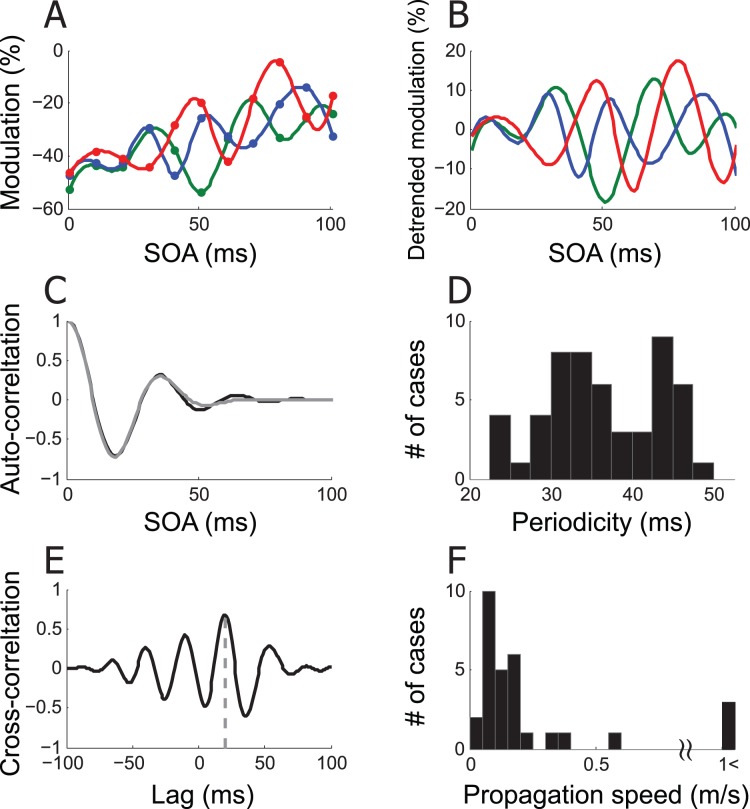
Periodic SOA-dependency of surround modulation.(A) Modulation of spike response in percentage as a function of SOA for three S1 locations of Fig. 5; green: a, blue: b, red: c. (B) Periodic component. The best fit linear trend was removed from the spline fit of modulation percentage in A for each S1 position to remove the monotonic component (detrend.m provided by the MATLAB). (C) The auto-correlogram (black) of the detrended modulation of S1a (green curve of B) was fit with a cosine-Gaussian function,  (gray). (D) Hstogram of periodicity. Each case is the first non-zero peak of a cosine-Gaussian function, taken from 53 out of 276 stimulus conditions, for which the cosine-Gaussian fit explained more than 90% variance of auto-correlation curve. For three examples of B, R-squares are 0.99 (S1a), 0.94 (S1b), 0.99 (S1c). The mean periodicity of 53 stimulus conditions is 36.62 ms. (E) Cross-correlation between detrended green and blue curves of B. The time lag at the maximum cross-correlation is 20 ms. This lag reflects the distance between S1a (green) and S1b (blue). Given that cortical distance between S1a and S1b was 3.07 mm, the propagation speed in this example is estimated to be 0.15 m/s. (F) Histogram of propagation speed. Shown is propagation speed for each of 30 cases in which at least one S1 position passed the periodicity criteria of C. The mean distribution is 0.14 m/s without 3 outliers. The median is 0.11 m/s.